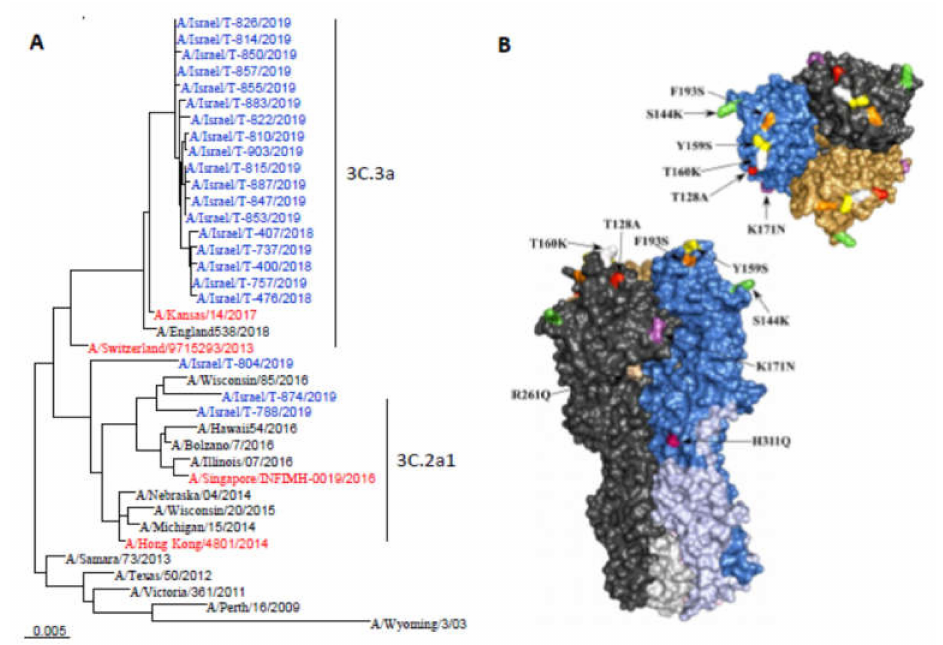
Figure 2. ( A ) Phylogenetic tree of hemagglutinin gene sequences of influenza A (H3N2) viruses obtained from ILI patients, Israel, 2018–2019 season. Relevant influenza vaccine viruses appear in red letters. ( B ) Structure model of a representative influenza A (H3N2) virus belonging to the 3C.3a